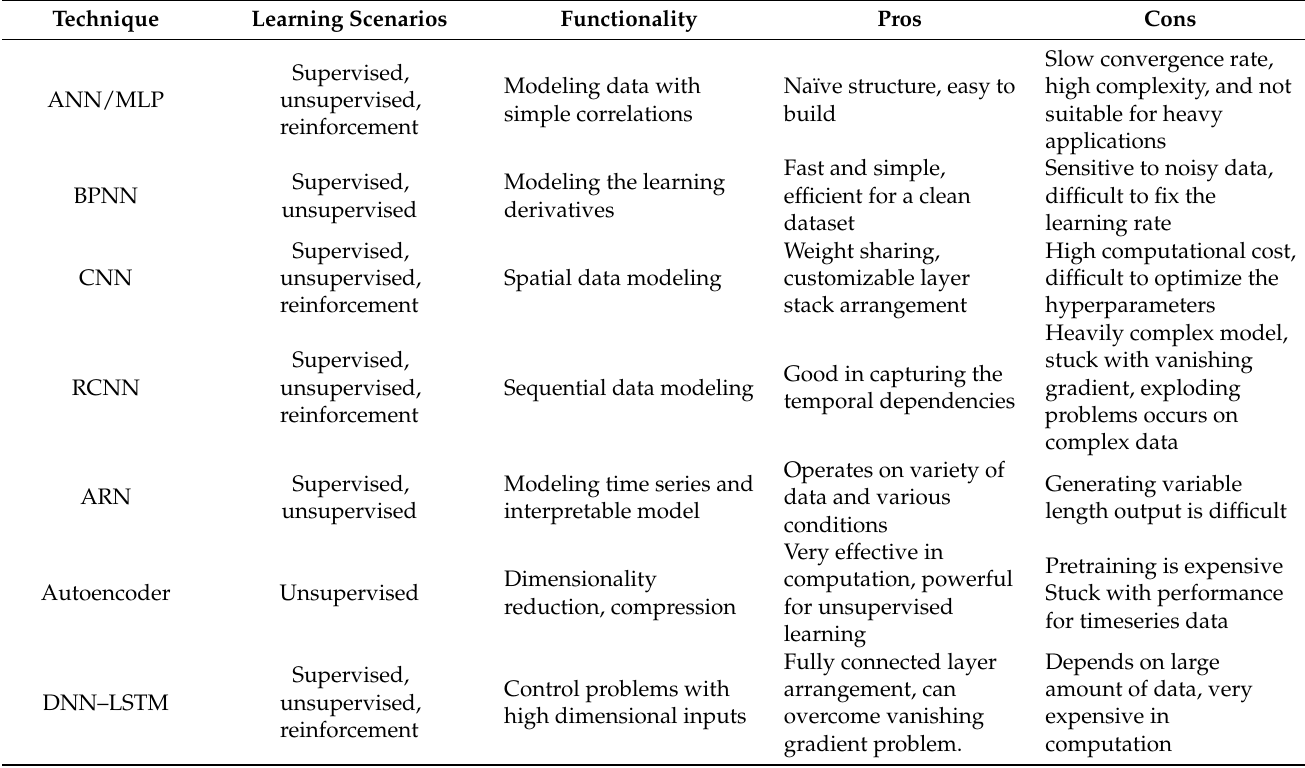
Table 1. Comparison of techniques used for data imputation and